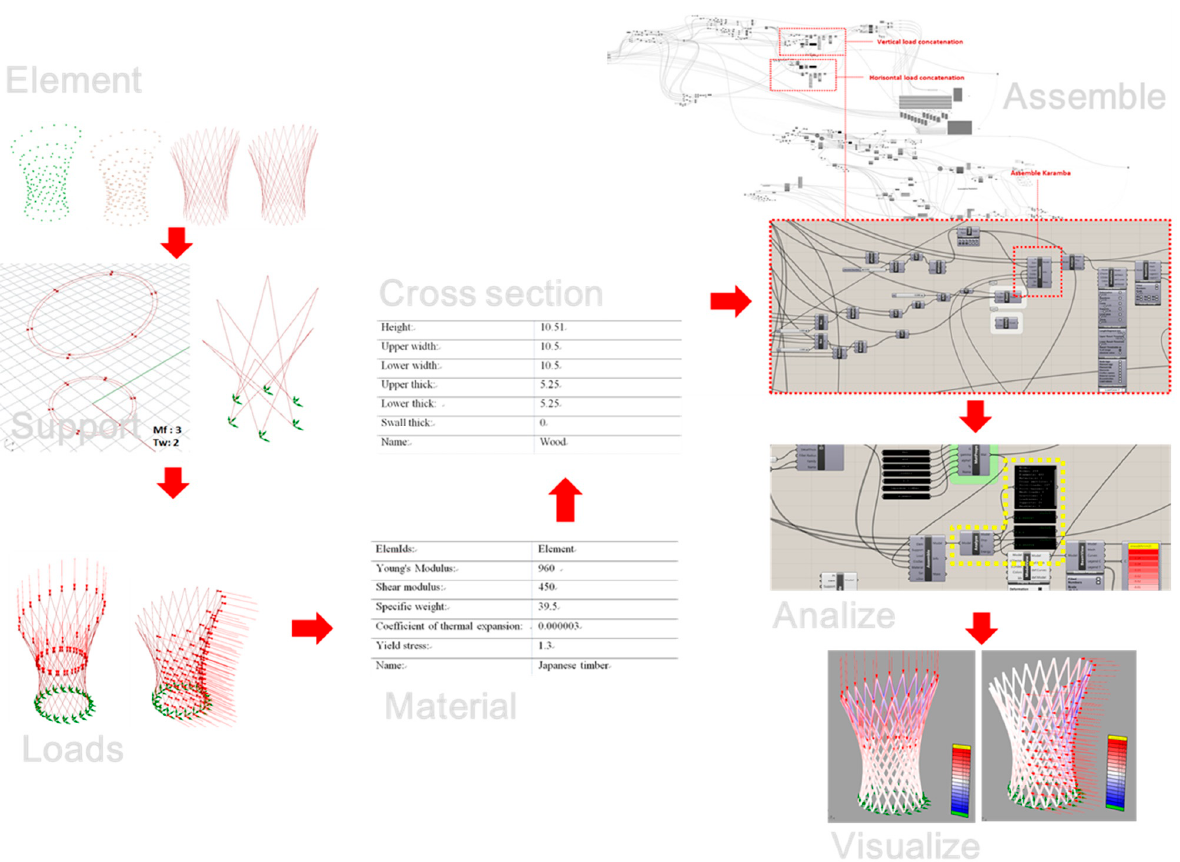
Figure 8. Structural modelling workflow .